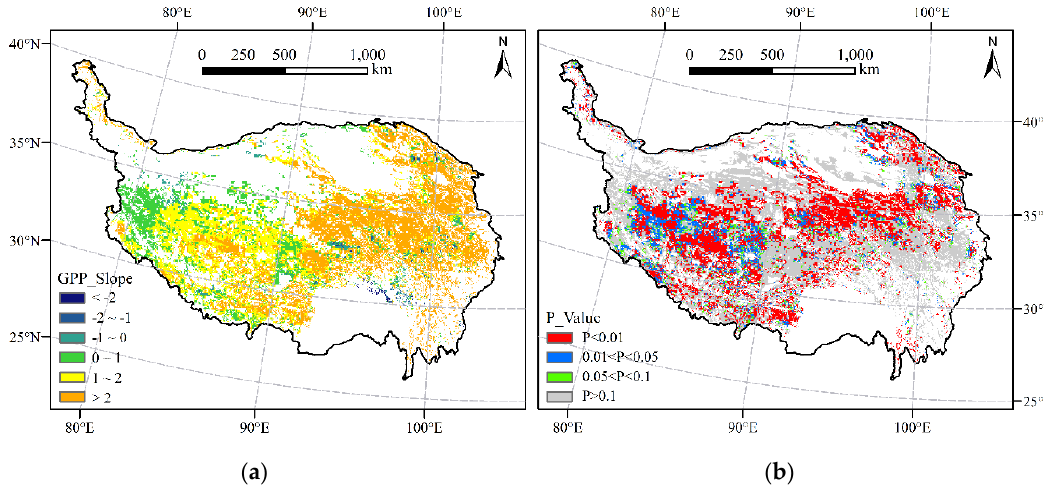
Figure 8. Spatial distribution of trends and significance levels of GPP of alpine grasslands on the TP from 1982 to 2015. ( a ) Trends of GPP; ( b ) Significance levels of GPP trends.